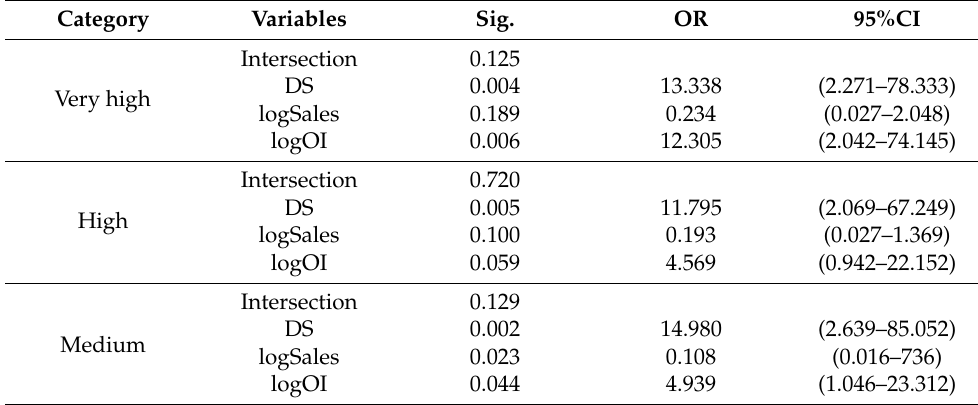
Table 5. The multinomial logistic regression results for the pharmaceutical PatientView reputa- tion